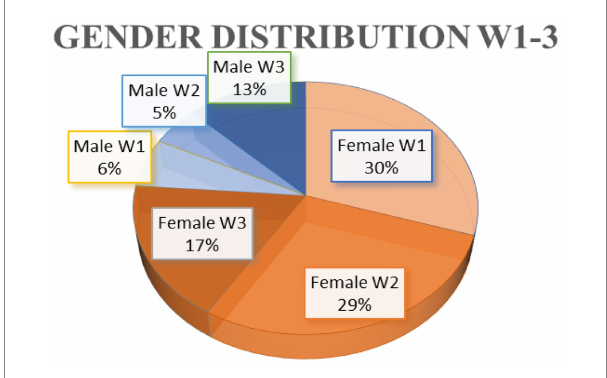
FIGURE 3 Gender Distribution of the participants in all held workshops.